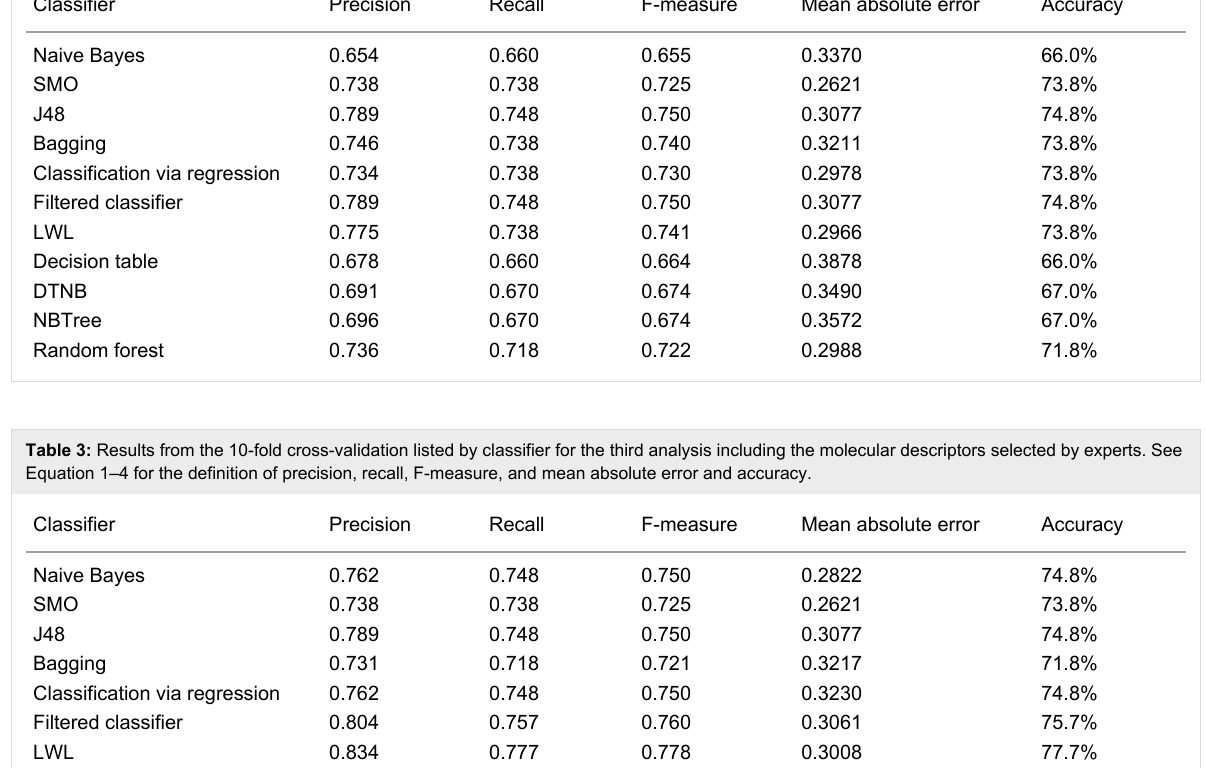
Table 2: Results from the 10-fold cross-validation listed by classifier for the second analysis including the automatically feature-selected molecular descriptors. See Equation 1–4 for the definition of precision, recall, F-measure, and mean absolute error and accuracy. Classifier